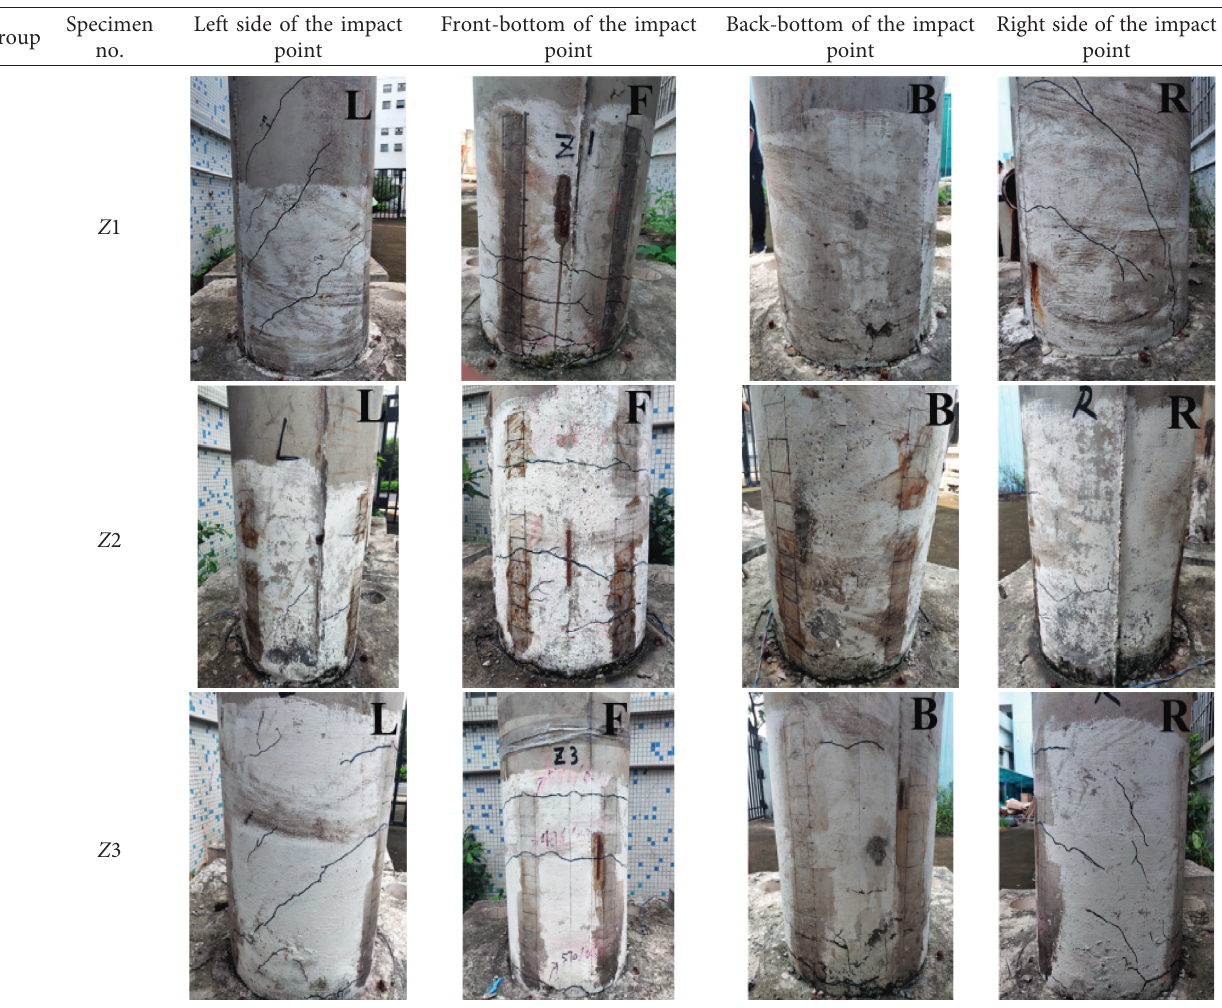
Table 7: Ultimate crack development and failure modes of the